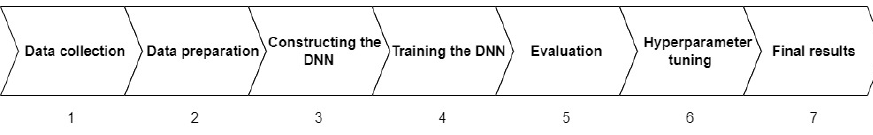
Figure 2. An overview of the steps taken to build and evaluate the Deep Learning